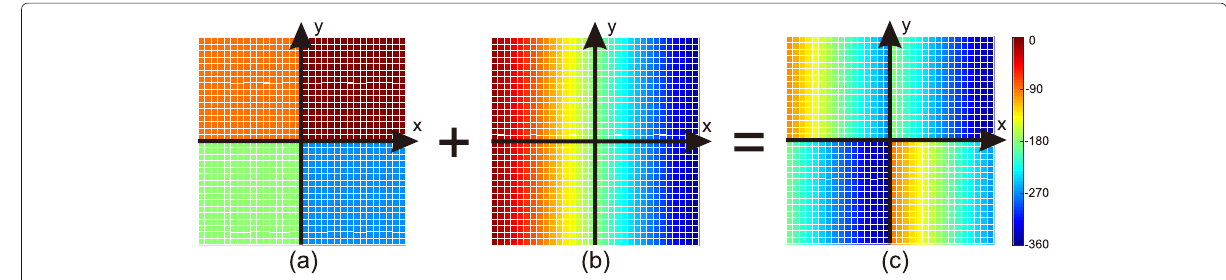
Fig. 6 Illustration of combination of phase discontinuity functions. a φ 1 , phase discontinuity distribution of MS 1 , which generates vortex electromagnetic wave with l = 1. b φ 2 , phase discontinuity distribution of MS 2 , which results in anomalous reflection. c Combined phase discontinuity distribution of the MS t calculated by Eq.